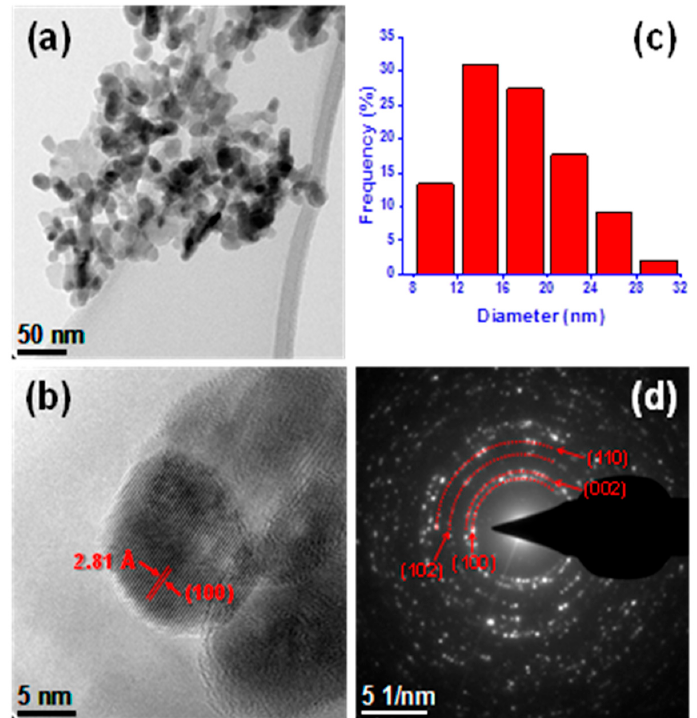
Figure 1. The micrographs show a zinc oxide nanoparticles (ZnO NP) sample. ( a ) Typical transmission electron microscopy (TEM) image of a nanoparticle, ( b ) Typical high resolution transmission electron microscopy (HRTEM) micrograph of a nanoparticle, ( c ) Size distribution of NPs ( d ) Typical selected area diffraction (SAED) pattern obtained for the area observed in panel (a).